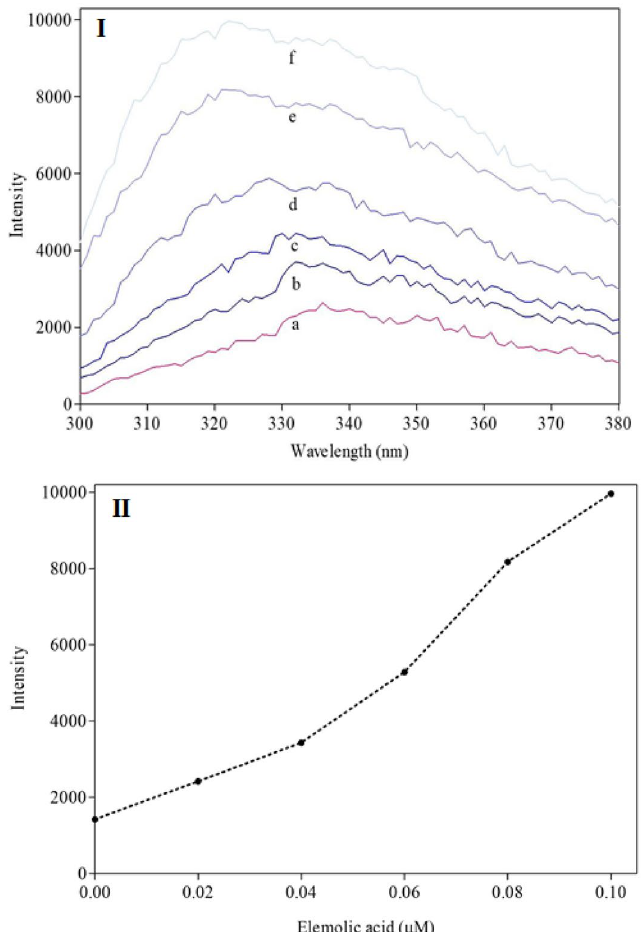
Figure 8. Intrinsic fluorescence spectra of GIIA enzyme with elemolic acid: ( I ) The spectra of ( a ) GIIA enzyme (20 µg/mL) alone, ( b ) with 0.02 µM, ( c ) 0.04 µM, ( d ) 0.06 µM, ( e ) 0.08 µM and ( f ) 0.1 µM of elemolic acid. ( II ) Maximum absorbance of fluorescence emission of GIIA enzyme after the addition of each concentration of elemolic acid was recorded.